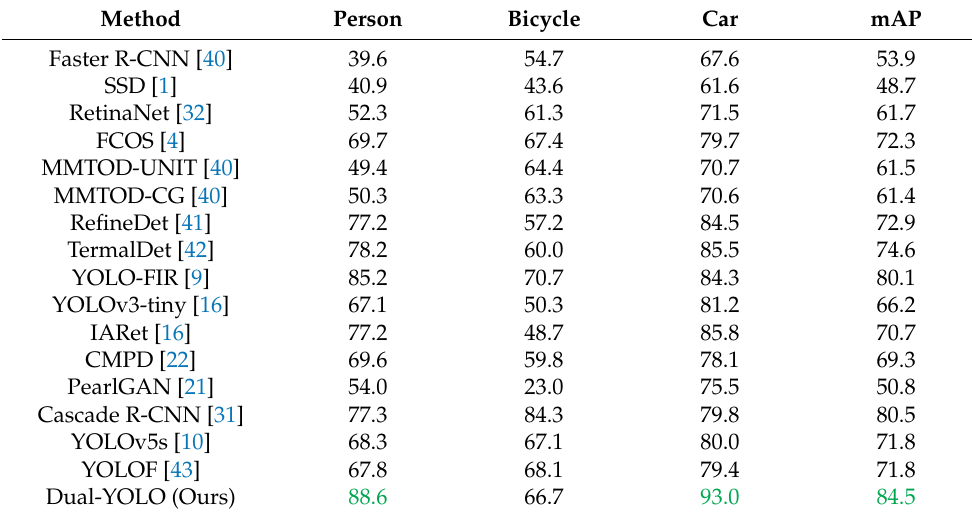
Table 6. Object detection results of the synthesized images obtained by different translation methods on FLIR dataset, were computed at a single IoU of 0.5. All values are in %. The top results are marked in